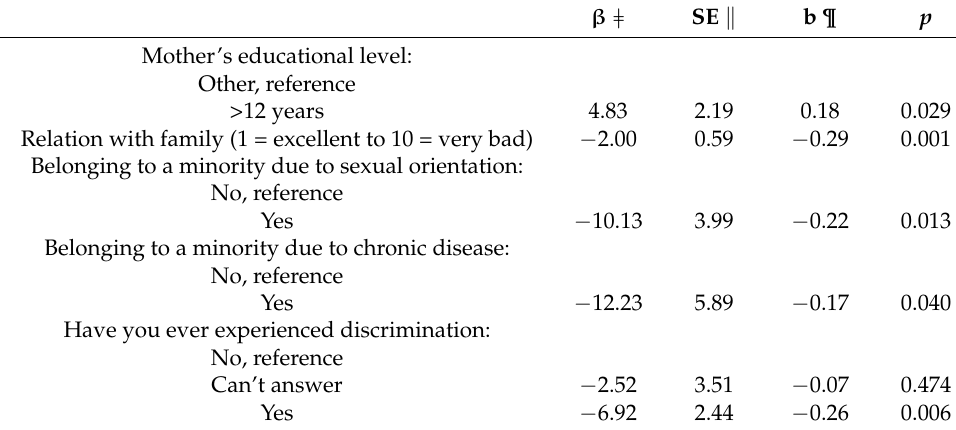
Table 4. Multiple linear regression analysis for mental wellbeing